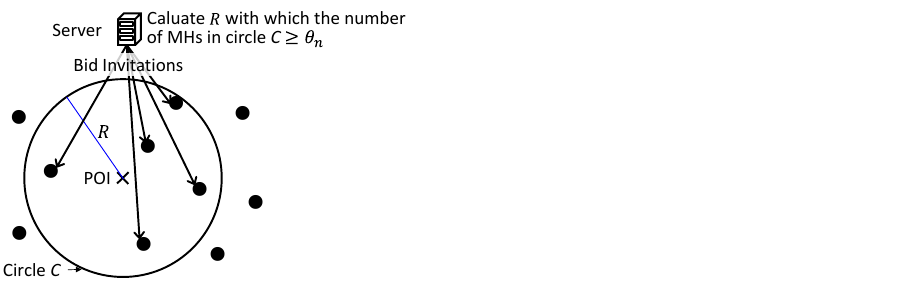
Figure 4. How to select mobile hosts that can obtain data for a data request (existing method, for 𝜃 𝑛 = 5 ).